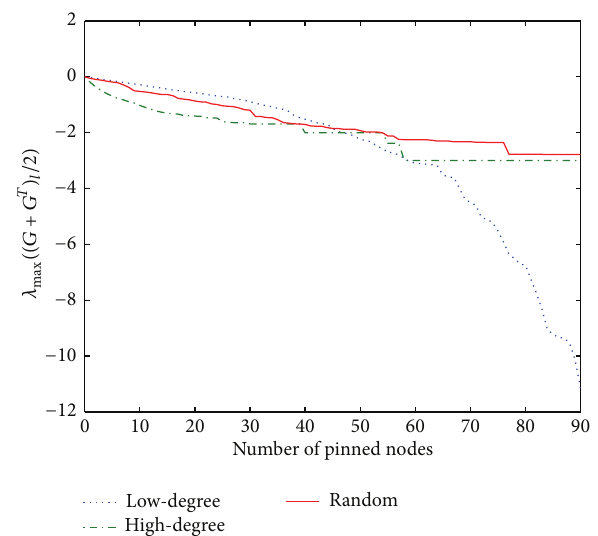
Figure 2: Orbits of 𝜆 max (((1/2)(𝐺 + 𝐺 𝑇 )) 𝑙 ) as functions of the number of pinned nodes by high-degree, low-degree, and random pinning